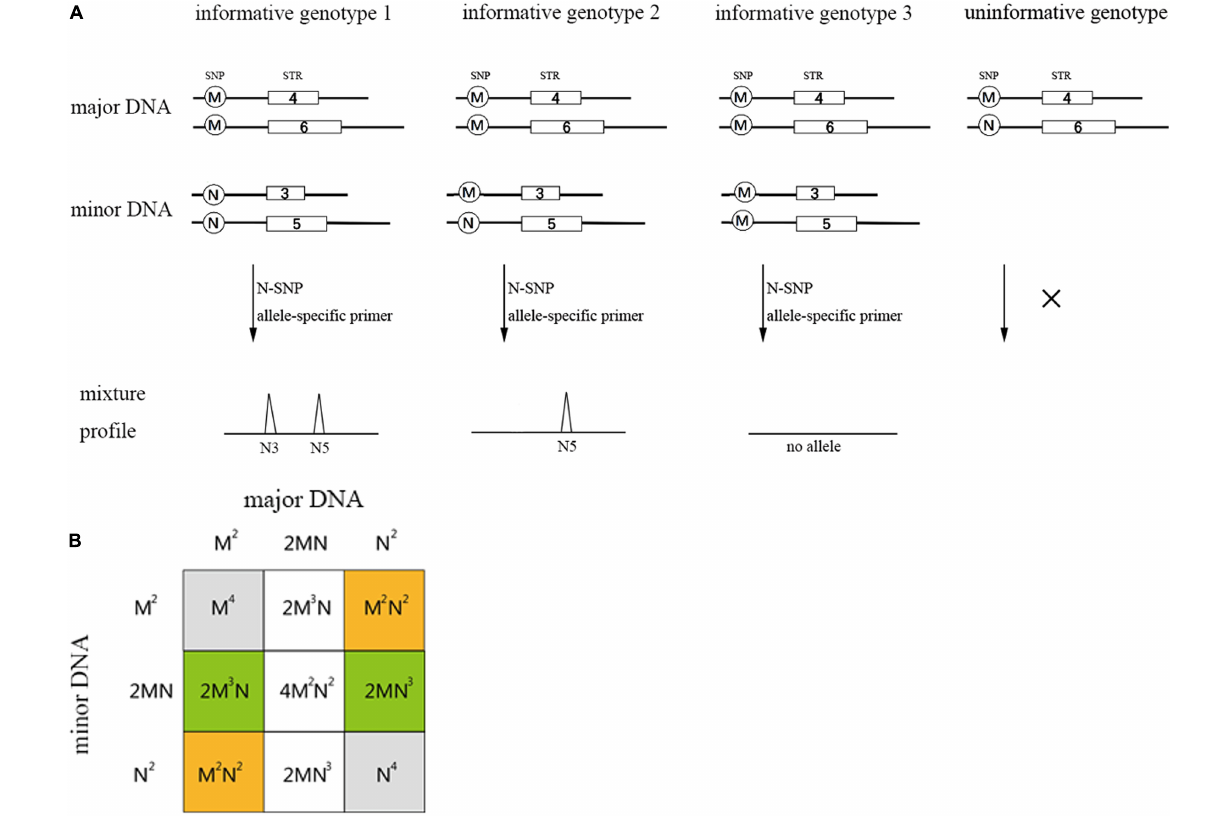
FIGURE 2 | Possible genotype sets of the two contributors in a two-person mixture (A) and the probability table for all possible combinations (B) . The orange regions represent informative genotype 1 and the green regions represent informative genotype 2. Gray and blank represent informative genotype 3 and uninformative genotype, respectively. M and N in (B) represent the biallelic SNP allele frequency of an SNP-STR locus. The probability of informative genotypes for one SNP-STR locus is: I = M 2 N 2 + M 2 N 2 + 2M 3 N + 2MN 3 = 2M 2 N 2 + 2M 3 N + 2MN 3